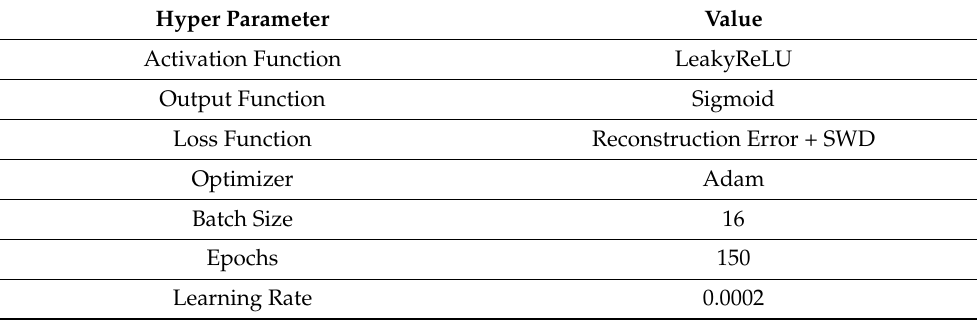
Table 3. Hyperparameter setting of the SWAE model.